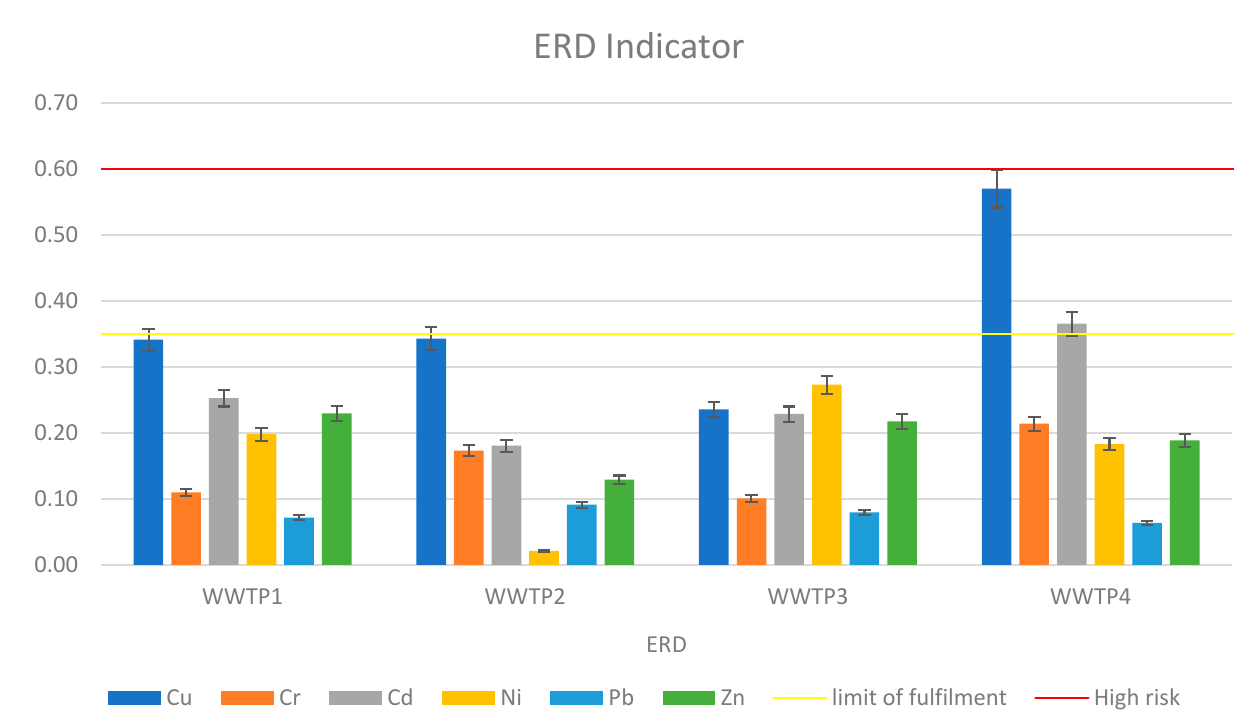
Figure 5. The environmental risk determinant (ERD) indicator of heavy metals in sewage sludge.